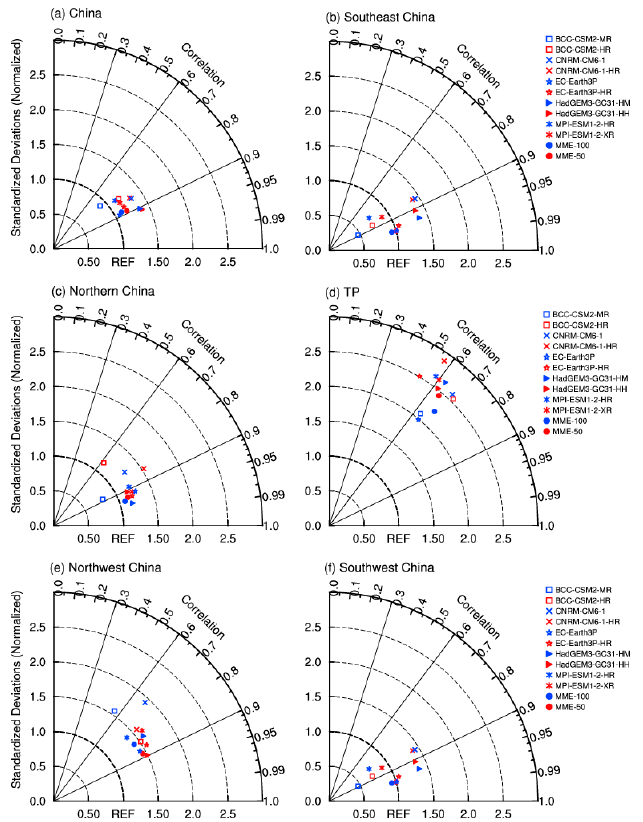
Figure 3. Taylor diagrams of the climatological mean precipitation over ( a ) China, ( b ) Southeast China, ( c ) Northern China, ( d ) TP, ( e ) Northwest China, and ( f ) Southwest China simulated by the models.